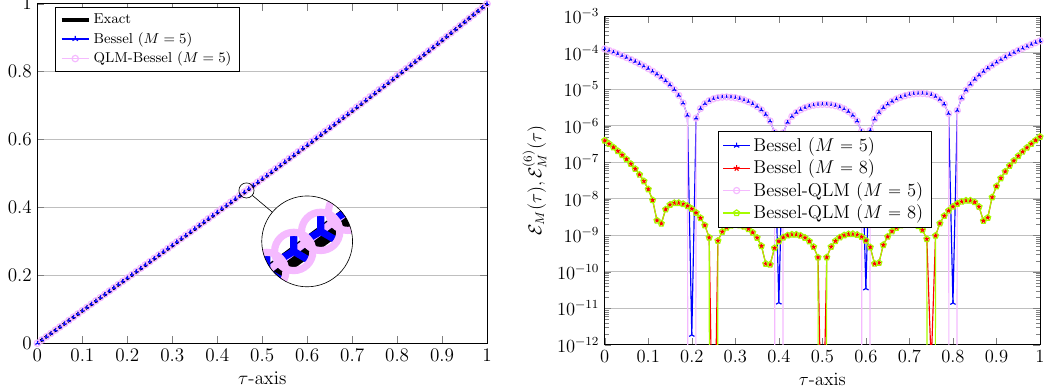
Figure 1. The graphs of exact and approximated solutions ( left ) and the related residual error functions ( right ) for M = 5,8, and r = 5 in Test case 1.